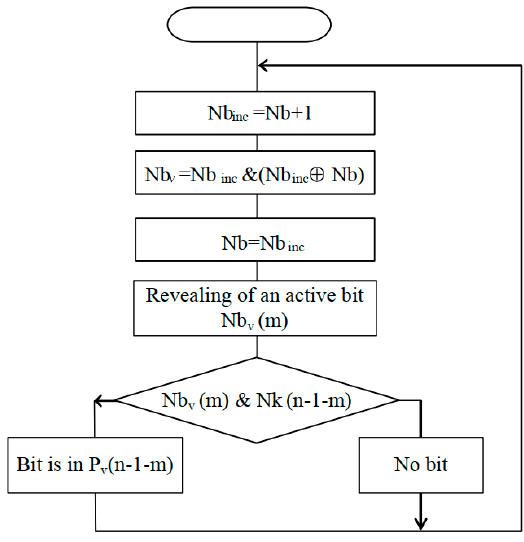
Figure 2. Algorithm of pulse-frequency sweep.